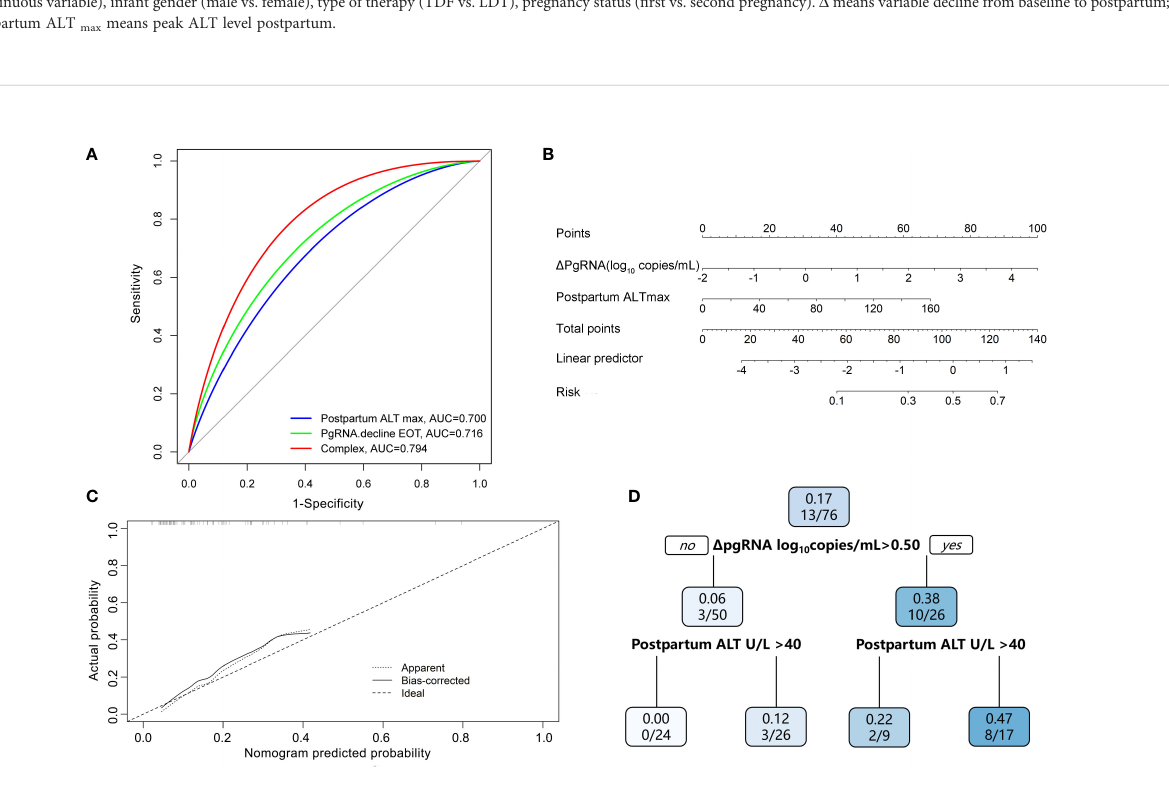
FIGURE 4 Predictive model of HBsAg reduction. (A) AUC performance of D pgRNA at the end of treatment (EOT), Postpartum ALT max and their combinations. (B) Calibration curve for the combined prediction model to predict probability of HBsAg reduction. (C) Nomogram to predict probability of HBsAg reduction in pregnant CHB carriers with HBeAg positive. (D) A decision tree for the HBsAg reduction outcome predictive model. PgRNA decline EOT means decline from baseline to postpartum; Postpartum ALT max means peak ALT level